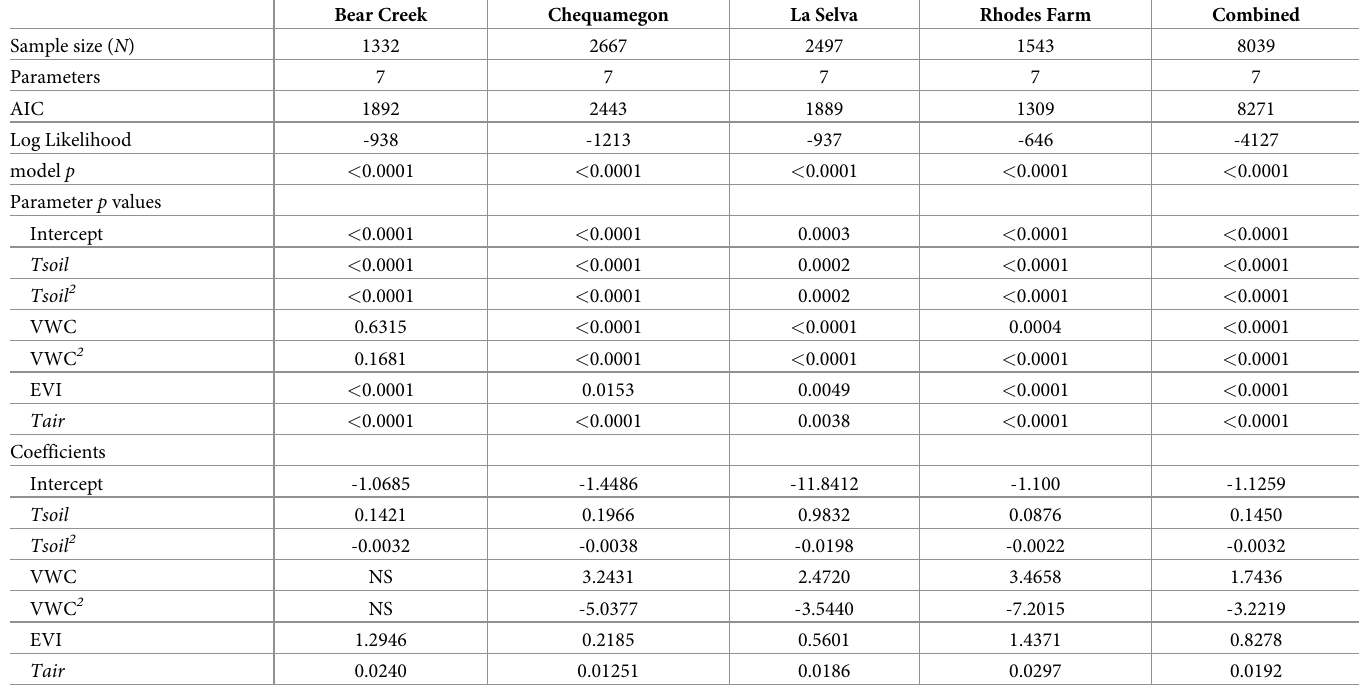
Table 4. Summary of the main-effects